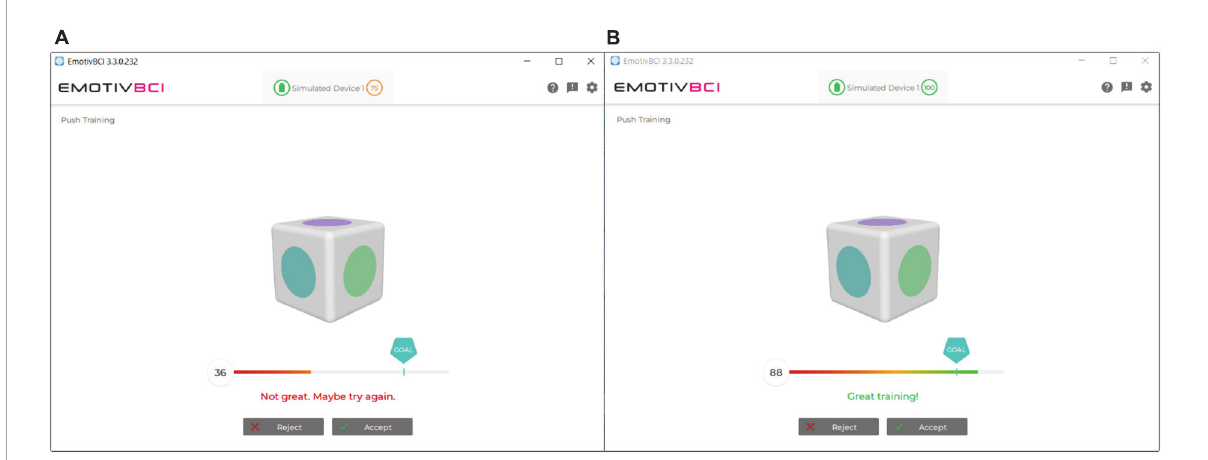
FIGURE5 Emotiv BCI App user interface with calibration score feedback. (A) Poor calibration trial. Trials with such scores were rejected and re-attempted. (B) Great calibration trial. Scores with this rating were